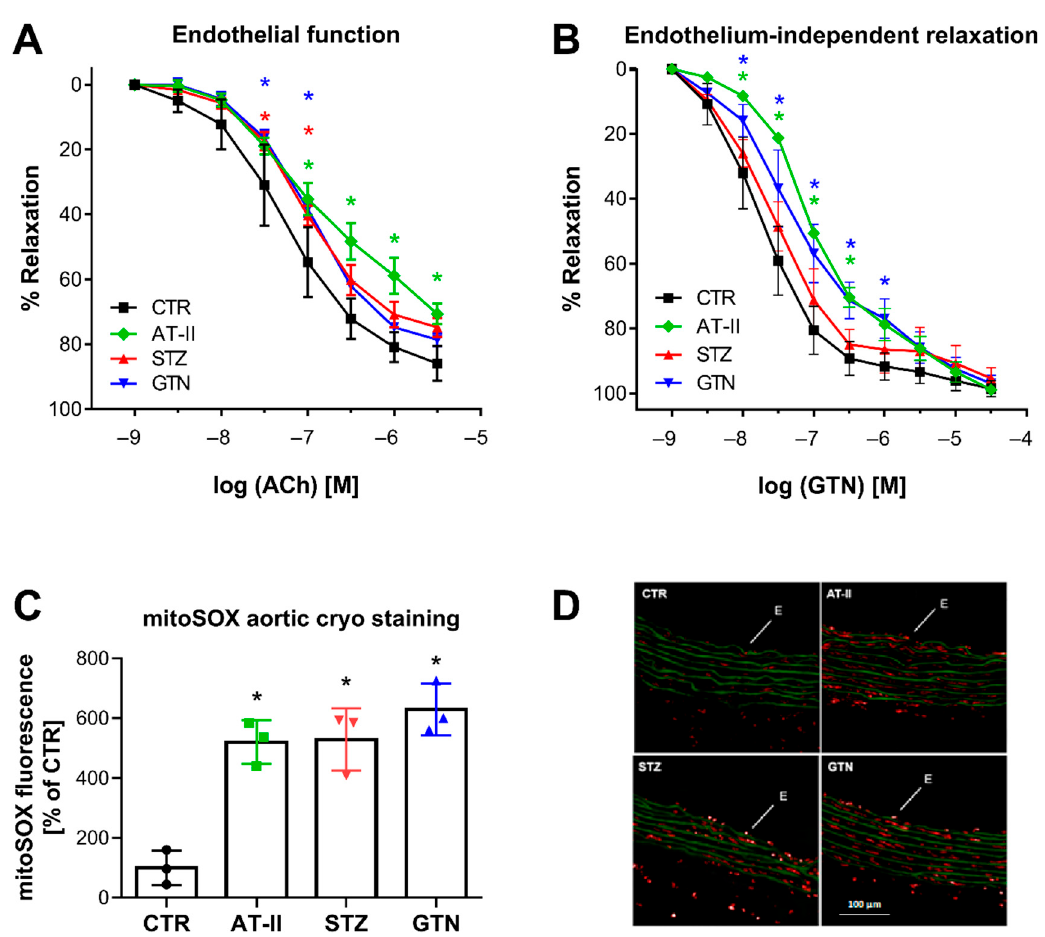
Figure 5. Vascular function and ROS formation of aorta from rats with preestablished cardiovascular disease or pharmacologically induced oxidative stress. Endothelium-dependent relaxation (ACh-triggered) ( A ) and endothelium-independent relaxation (GTN-triggered) ( B ) was determined by isometric tension method in aortic ring segments of hypertensive, diabetic and nitrate tolerant rats, and respective control animals. ( C ) Vascular ROS formation was determined by mitoSOX oxidative fluorescent microtopography in aortic cryo-sections. Representative fluorescence images are shown with red fluorescence for mitoSOX oxidation products and green fluorescence for autofluorescence of the basal laminae ( D ). Data are mean ± SD of 7 (Ctr, A , B ), 3 (AT-II, STZ, GTN, A,B) and 3 ( C ) rats per group. Each single animal data point was generated from 3–4 ( A , B ) or 3 ( C ) technical replicates. * p < 0.05 vs. control group.